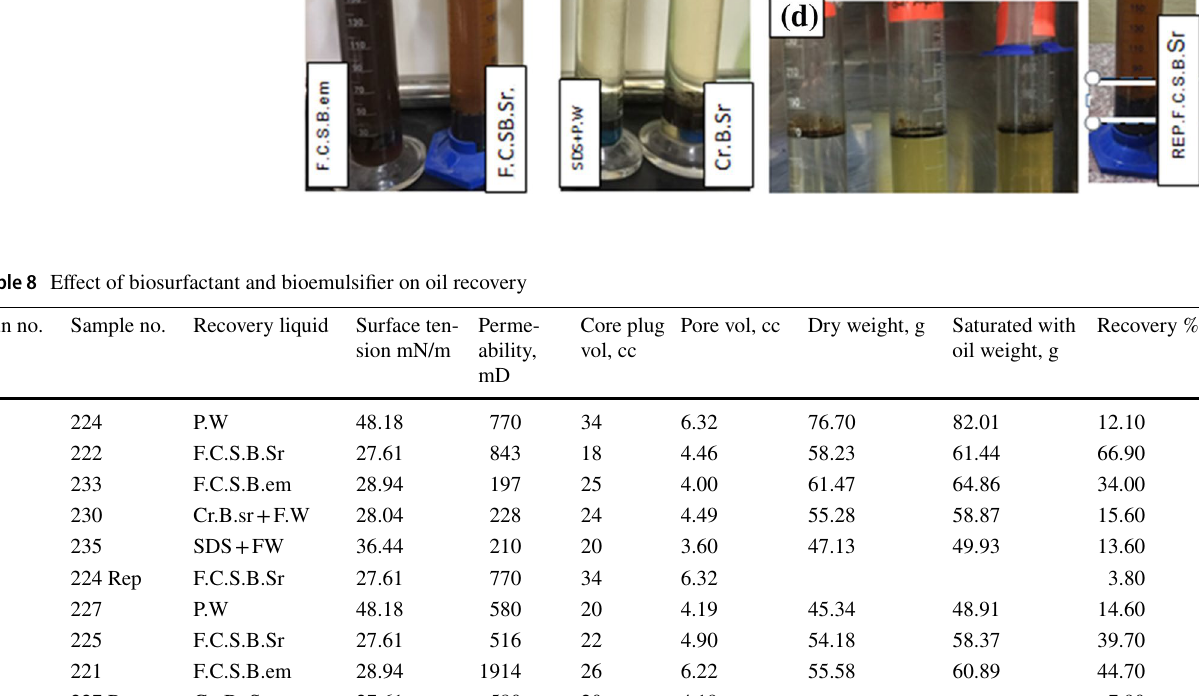
Fig. 9 a and b Imbibition experiments with different liquids. c Oil flow from surface of cores. d Rise of oil above the liquid surface. e Repeated treat- ment core 224 with F.C.S.B.sr after FW